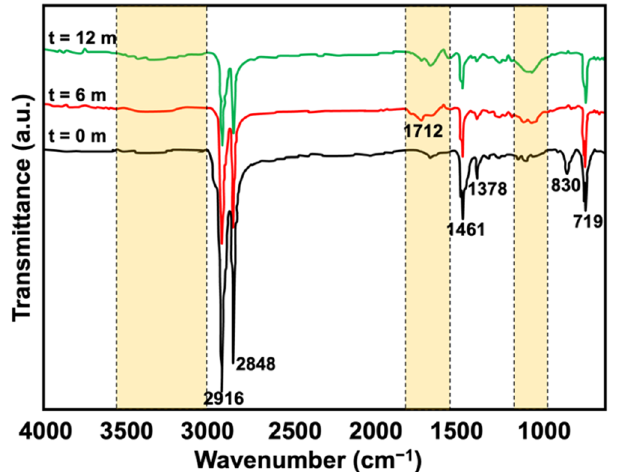
Figure 11. FTIR spectra of KP-filled rHDPE/NR blends before and after 6 and 12 months of natural weathering.